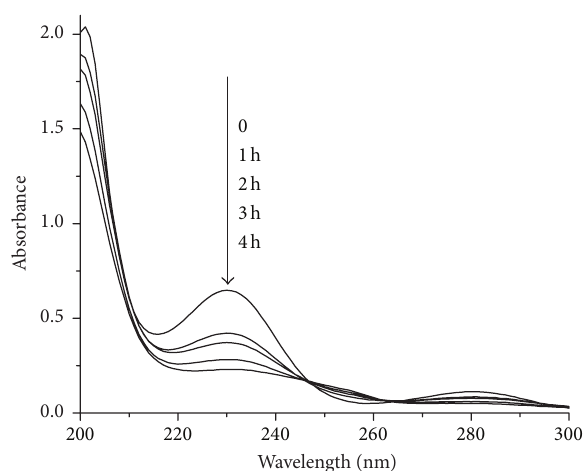
Figure 4: The changing relation of UV-vis absorption spectra during the aniline degradation